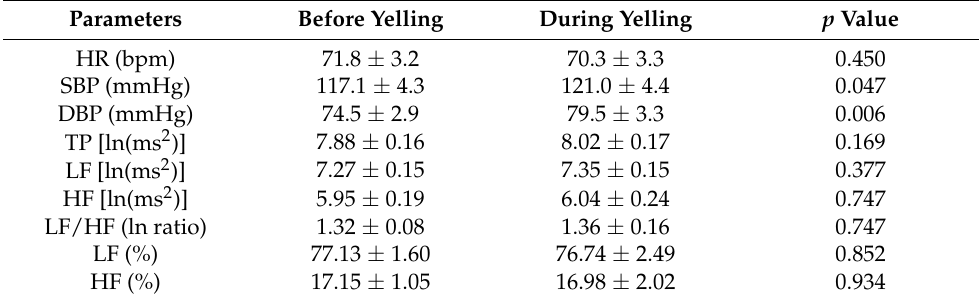
Table 2. Effects of simple yelling at rest on various physiologic measurements ( n = 13).